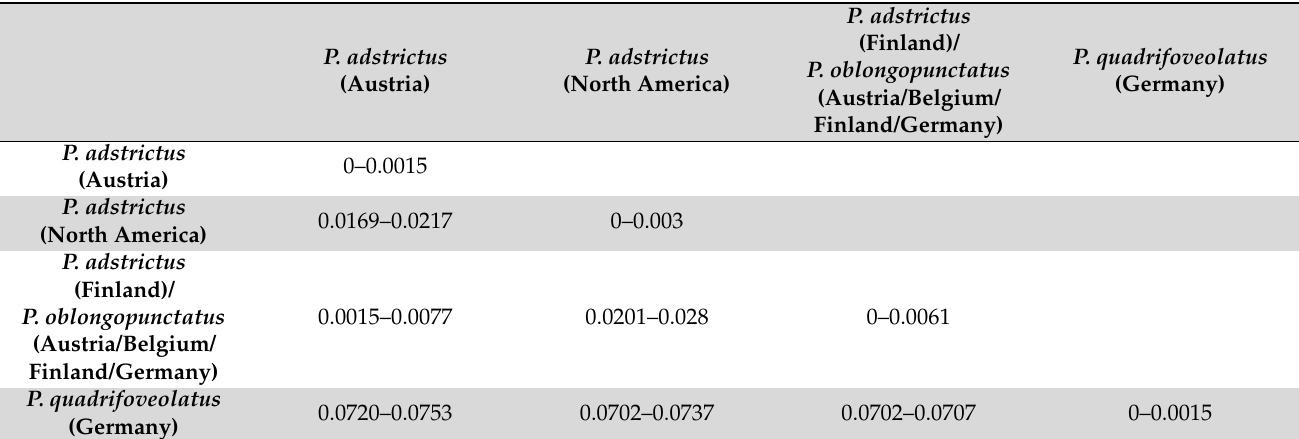
Table 3. Pairwise K2P-distances within and between distinct groups in the haplotype network (Figure 5).